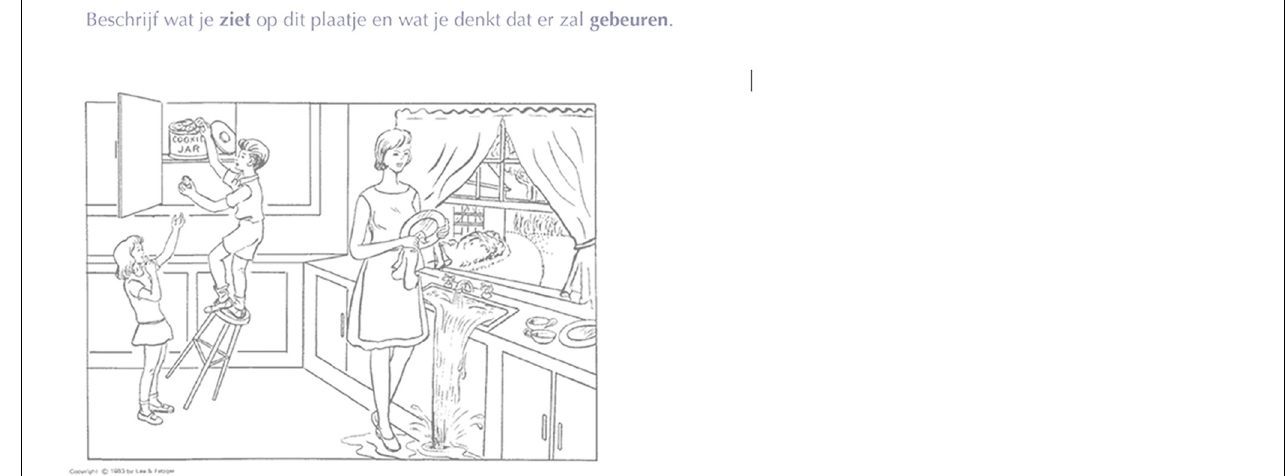
FIGURE 2 | Word template including the Cookie Theft picture.